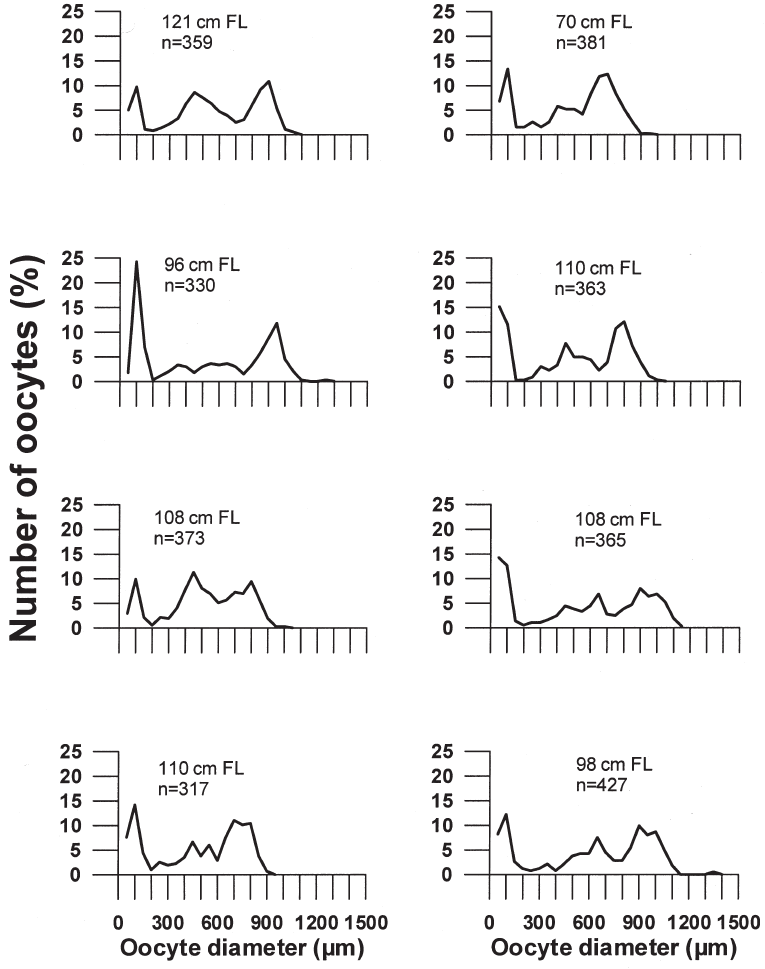
F IG . 5. – Individual dolphinfish oocyte size frequency distributions showing different developmental stages of whole oocyte obtained from 8 female gonad